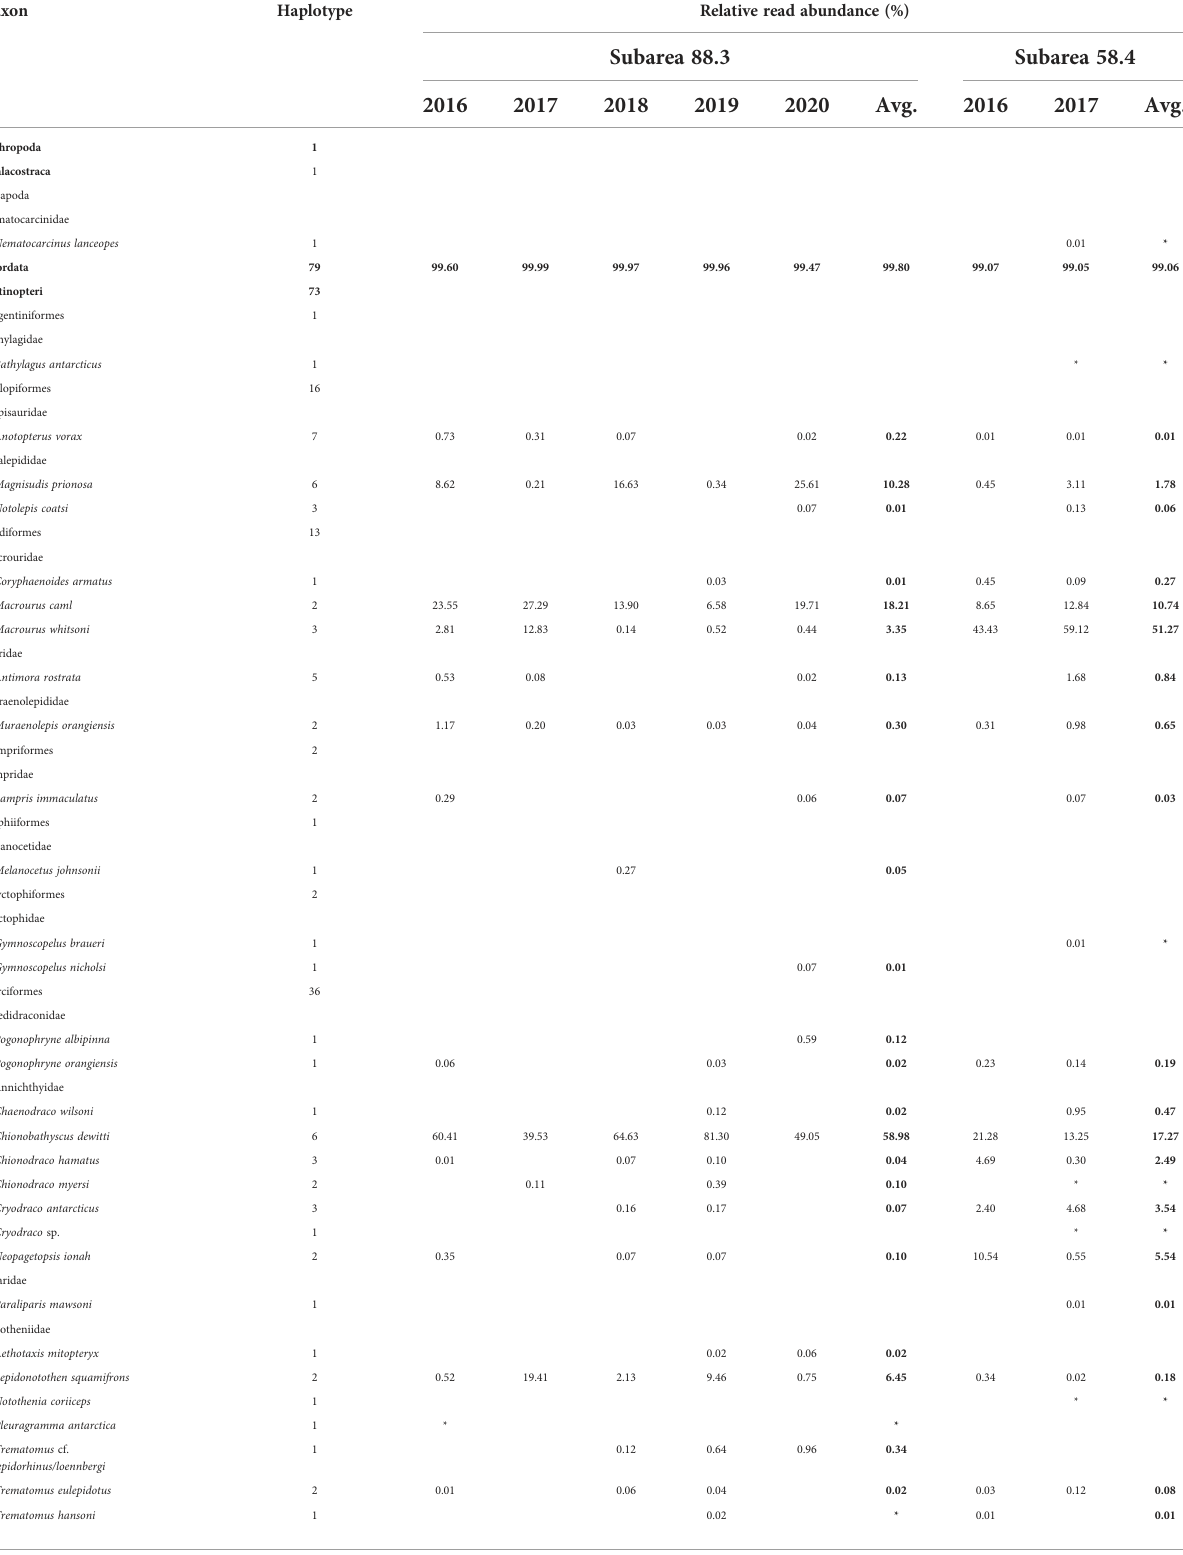
TABLE 3 Prey organisms of Dissostichus mawsoni in subareas 88.3 and 58.4. Taxon Haplotype Relative read abundance